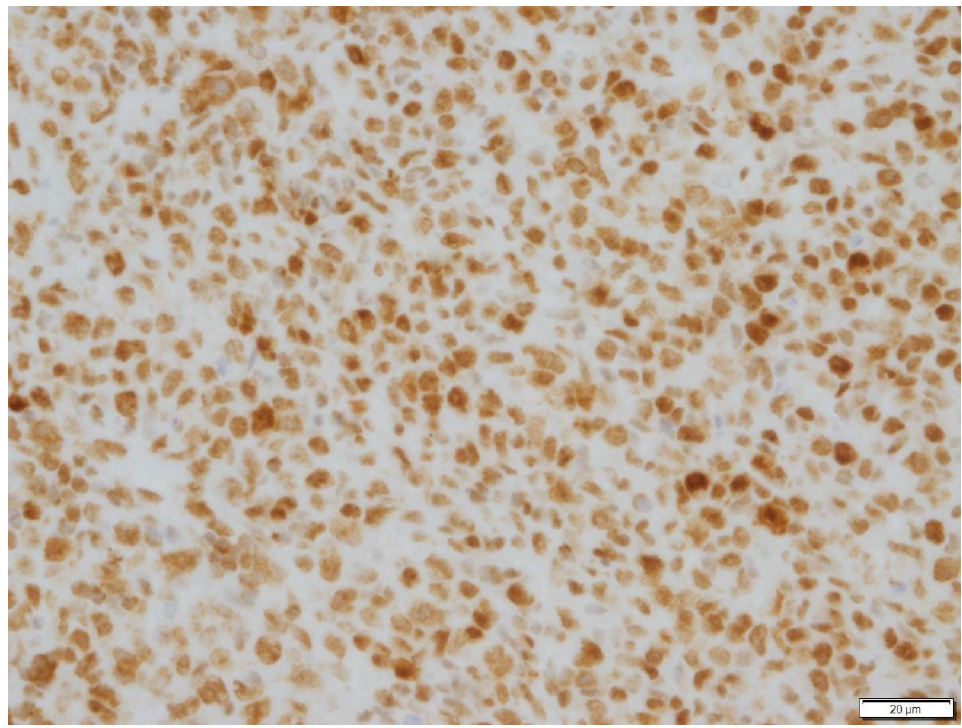
Figure 3. Immunohistochemical stain of neoplastic cells in Case N.1. Neoplastic cells exhibited strong immunoreactivity for CD79a. Immunohistochemical stain CD79a (400× magnification).